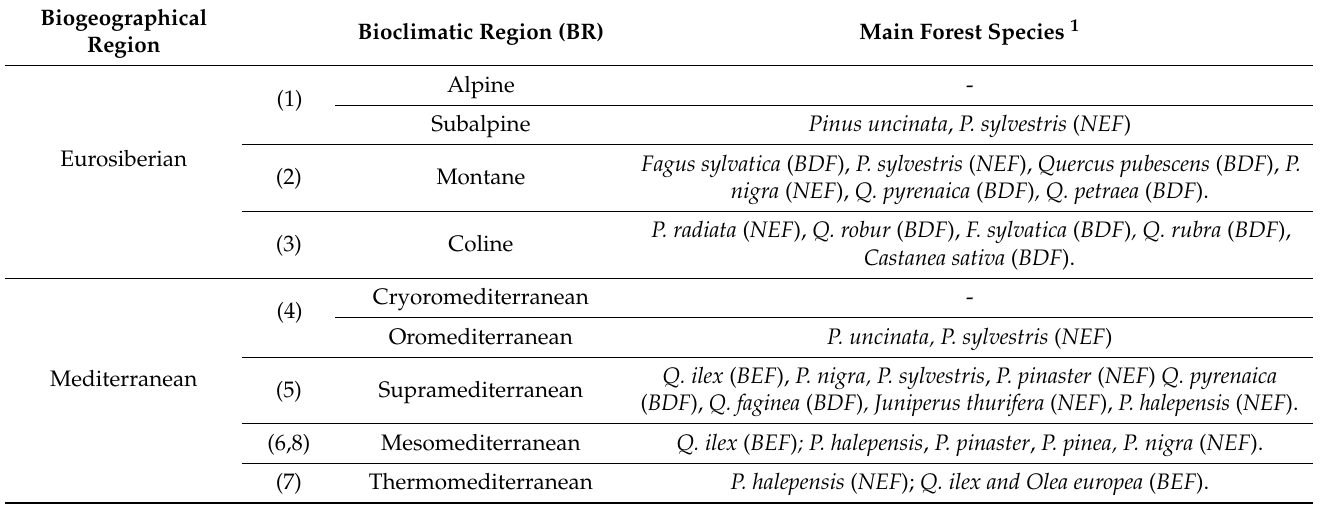
Figure 1. The transect along the Iberian Peninsula used in this study is shown in ( a ) and the land cover map (LCM) of 1987 in ( b ). Table 1. Main forest species in BRs surveyed in the transect. BR numbers are related to other figures in the